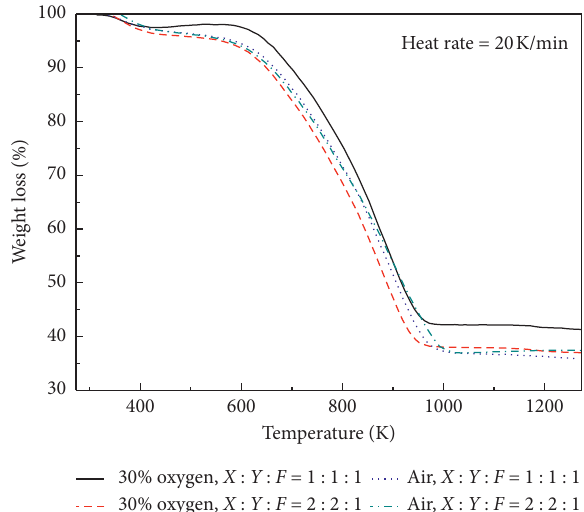
Figure 1: Effect of oxygen concentration on pyrolysis of blended coal with different mass ratios.